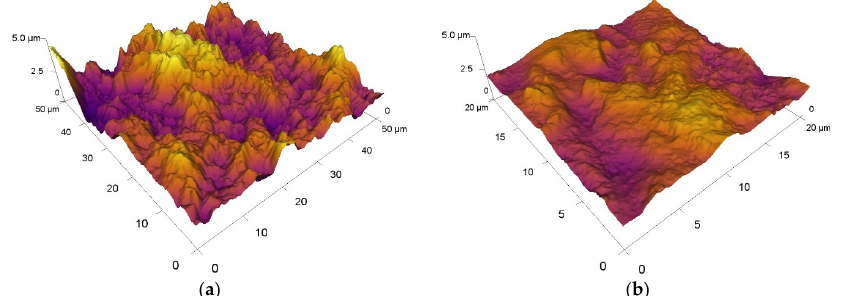
Figure 15. Three-dimensional comparison of the roughness values of the ceramic ball Al 2 O 3 in contact with: ( a ) M390_600 and ( b ) M398_600.